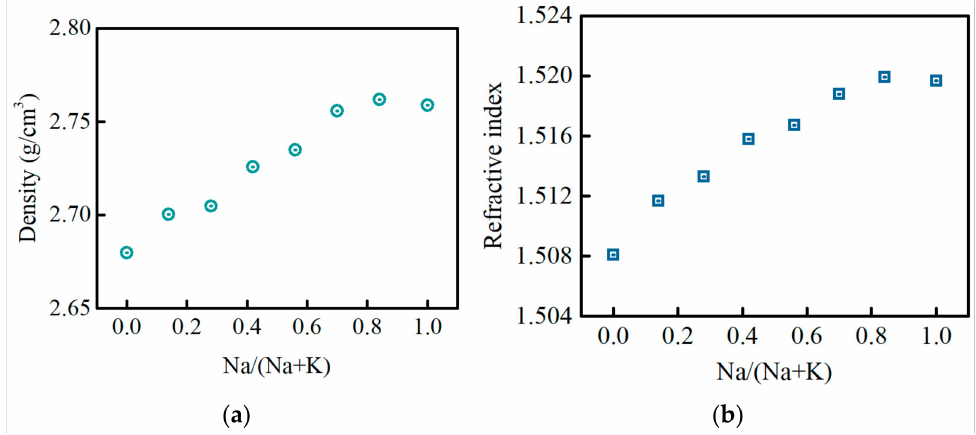
Figure 1. ( a ) Density ( ρ ) and ( b ) refractive index ( n ) at 656 nm of the PKNi glass with different Na/(Na+K) ratios.